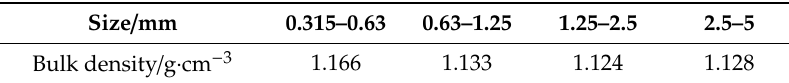
Figure 6. Gradation zone curve of CHPs. (E) Boundary line of the sand in Zone II.